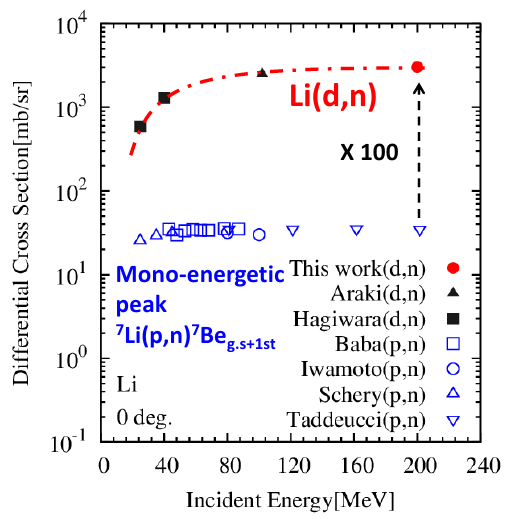
Figure 4. Measured di ff erential cross sections at 0 ◦ for the Li( d , xn ) reaction and the 7 Li( p , n ) 7 Be g . s + 1st reaction at incident energies between 25 MeV to 200